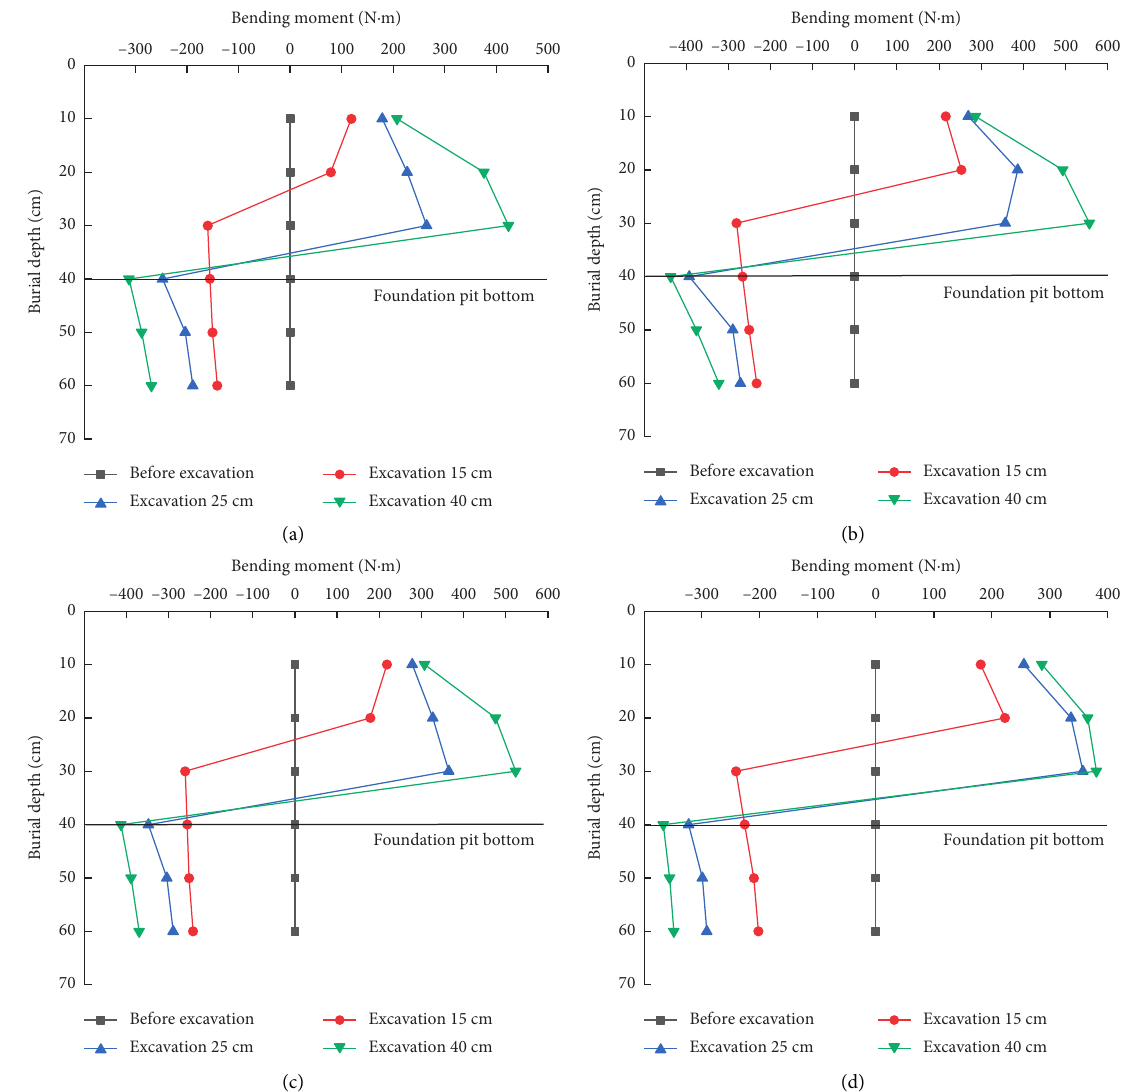
Figure 6: Distribution curves of the bending moment of pile body: (a) Pile #2. (b) Pile #4. (c) Pile #5. (d) Pile